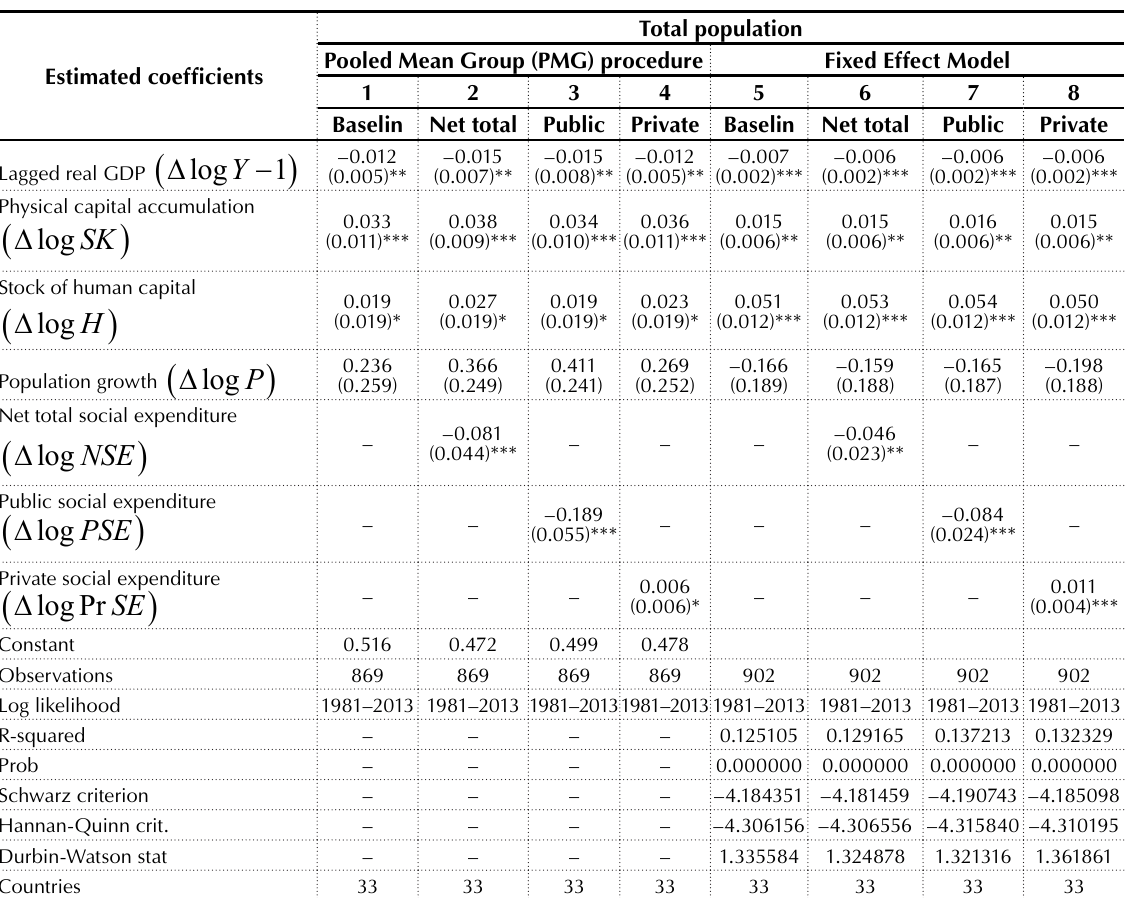
Table 8. Assessment of the social expenditure impact (public and private) on the economic growth Source: Authors’ calculation based on the OECD data. Retrieved from http://stats.oecd.org/ (application date – March 14,